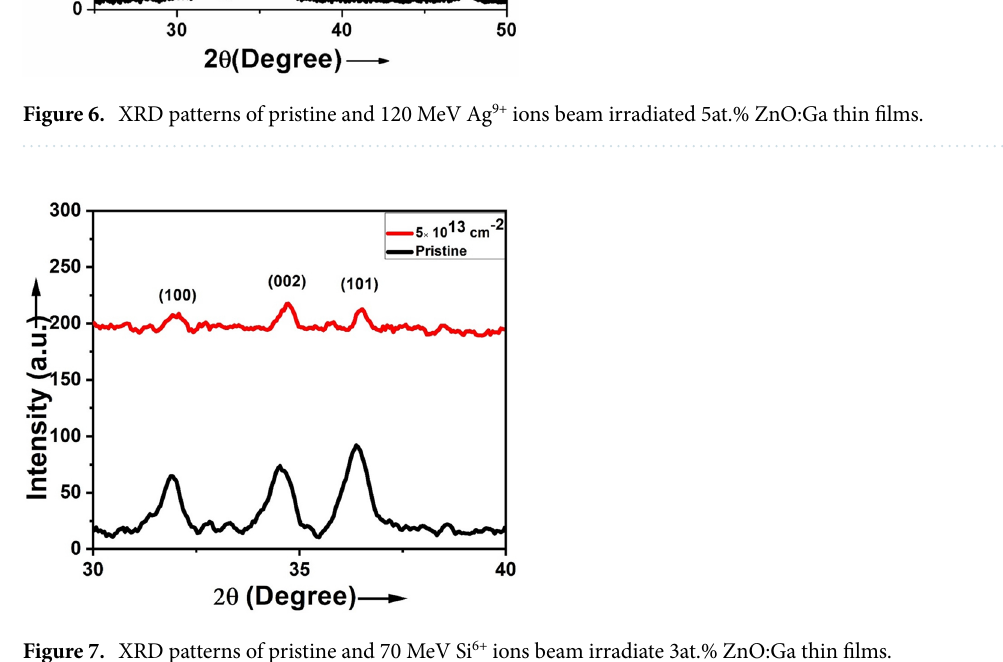
0.9 (cid:31) β cos θ